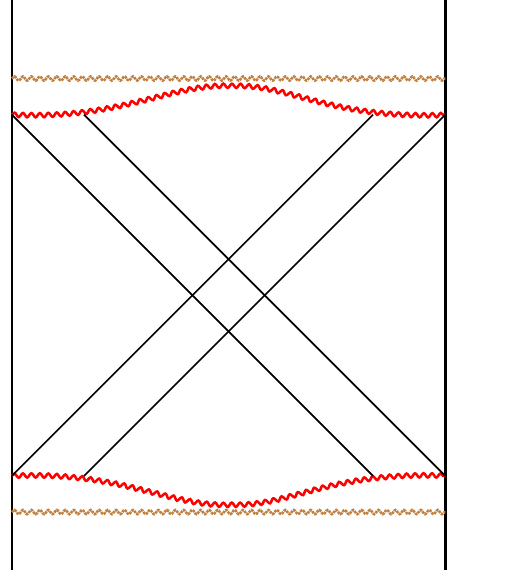
JHEP08(2018)140